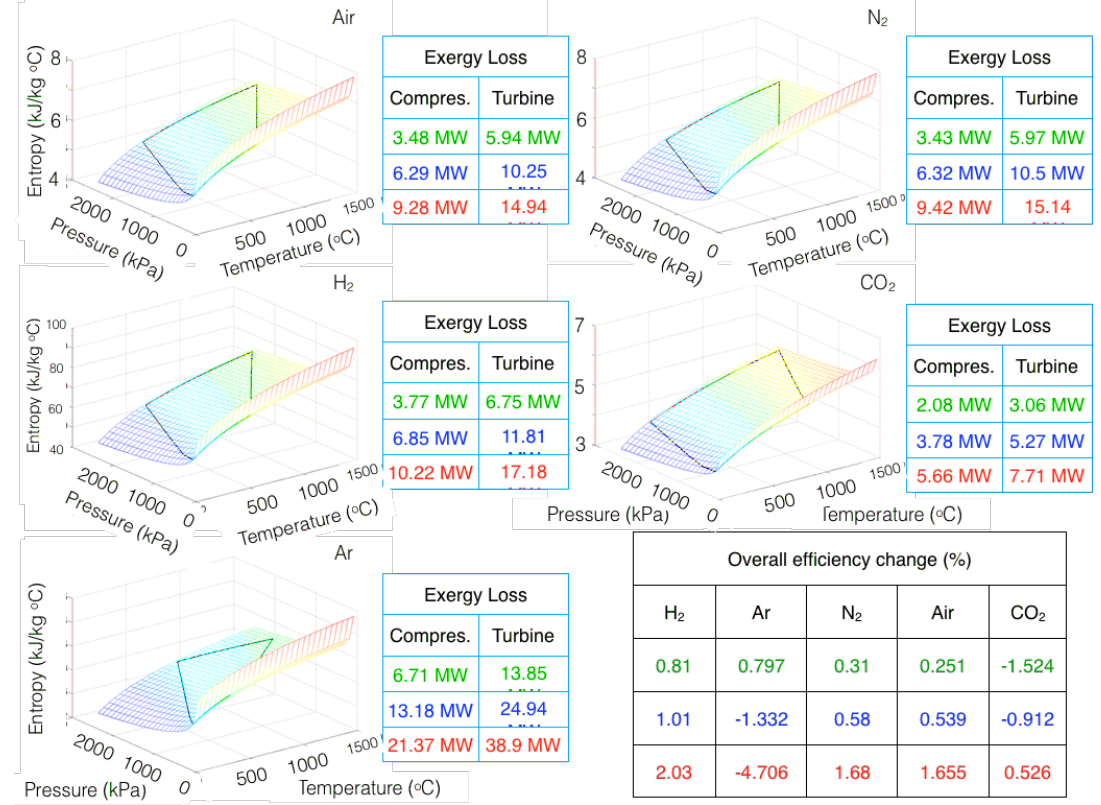
Figure 10. Entropy data for different fluids shown as 3D surface plots. Black lines represent the entropy profiles of the partitioned Brayton cycle at 92.7% adiabatic efficiency. Red and blue numbers represent the slope of the curves with respect to temperature and pressure, respectively. Adjacent tables provide the exergy loss in the compressor and turbine. Green, blue, and red represent these losses at adiabatic efficiencies of 95.63%, 92.7%, and 89.9%, respectively. The main table provides the overall efficiency change by the addition of partitioned cycle.